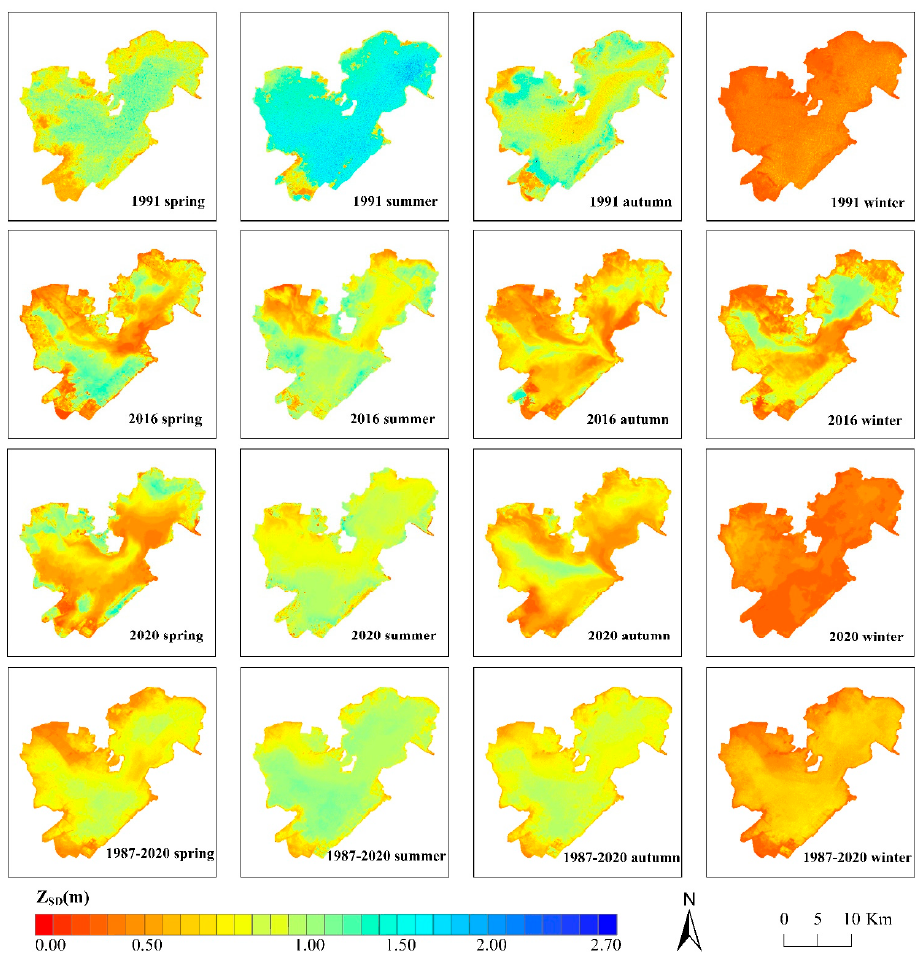
Figure 9. Time series of Landsat-estimated Z SD (mean value of the main area of Honghu Lake, the buffer zone generated 2 km inward from Honghu Lake boundary) by season from 1987–2020. The red lines are the trend lines of each season.